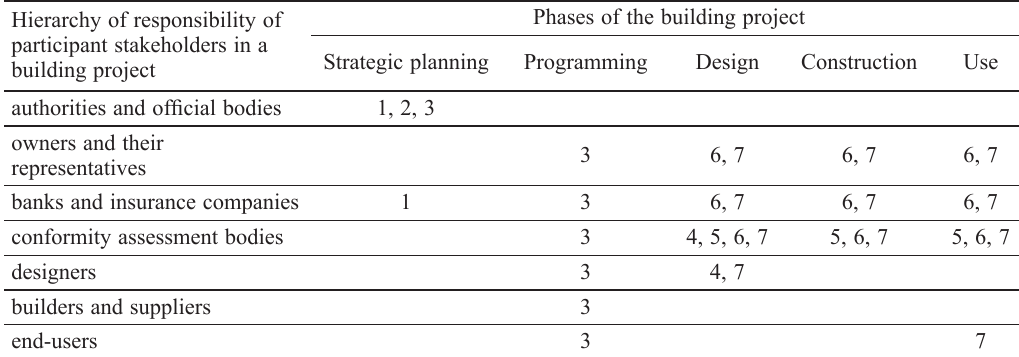
Table 7. Applicability of the seven elements of the proposed framework Hierarchy of responsibility of participant stakeholders in